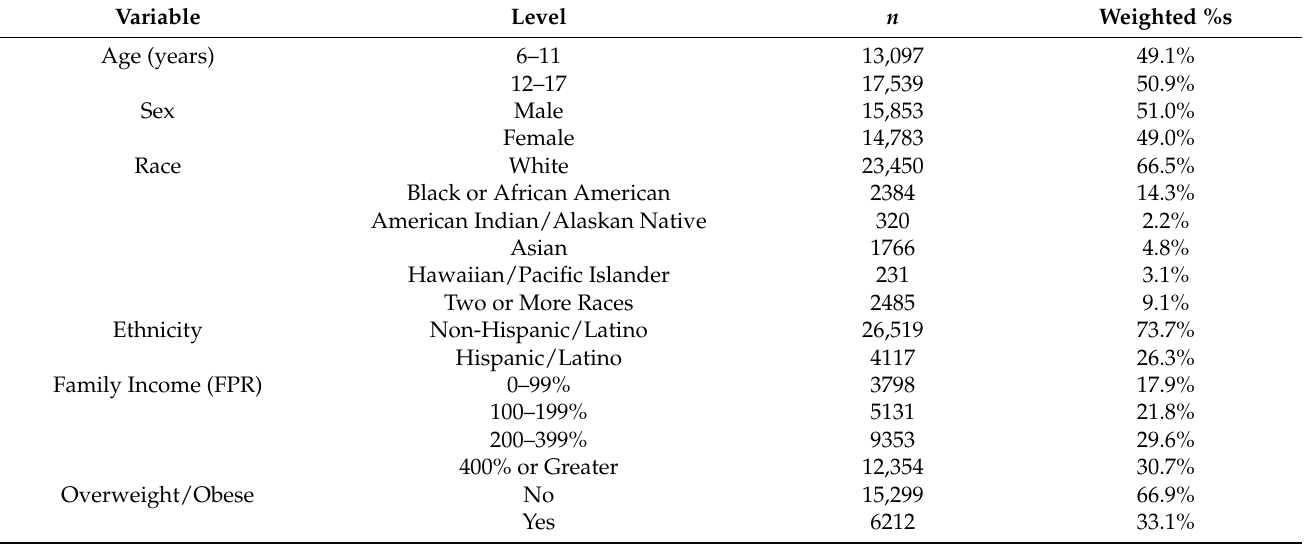
Table 1. Characteristics of the analyzed sample of participants from the National Survey of Chil- dren’s